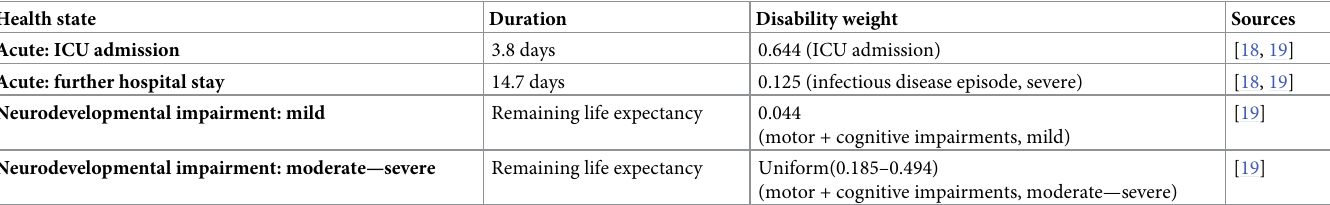
Table 1. Duration and disability weights for health